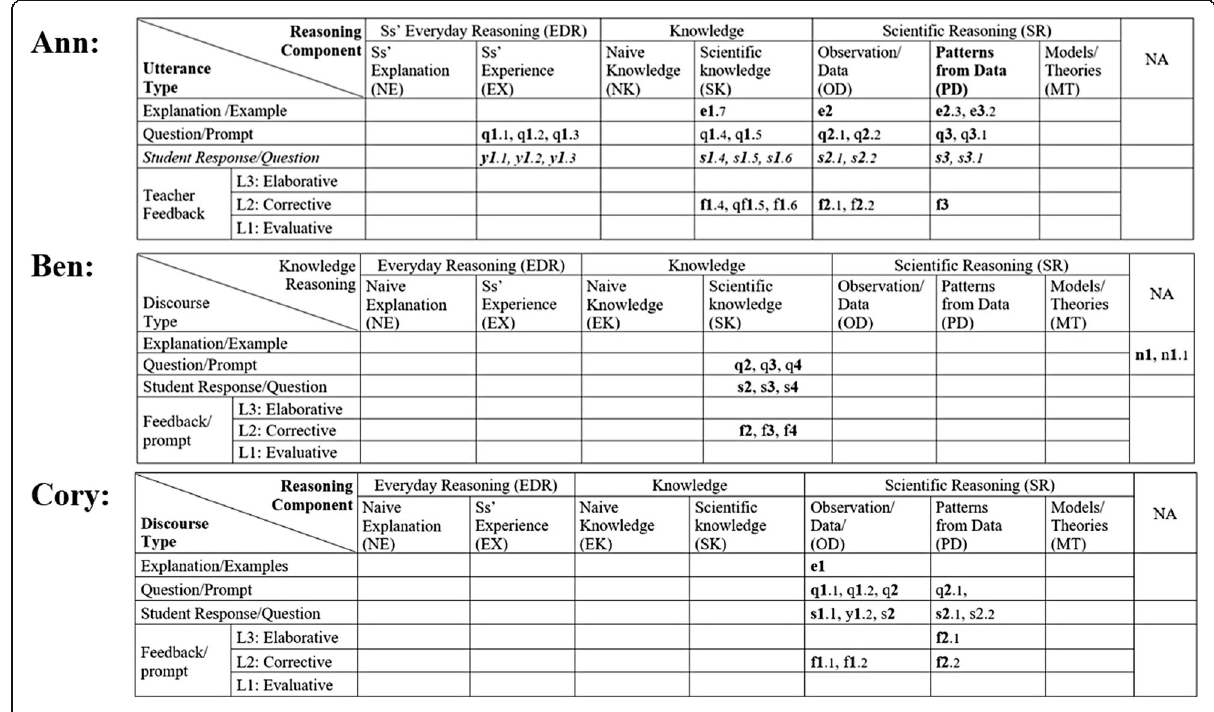
Fig. 7 Comparison of three different teachers ’ CDAT coding